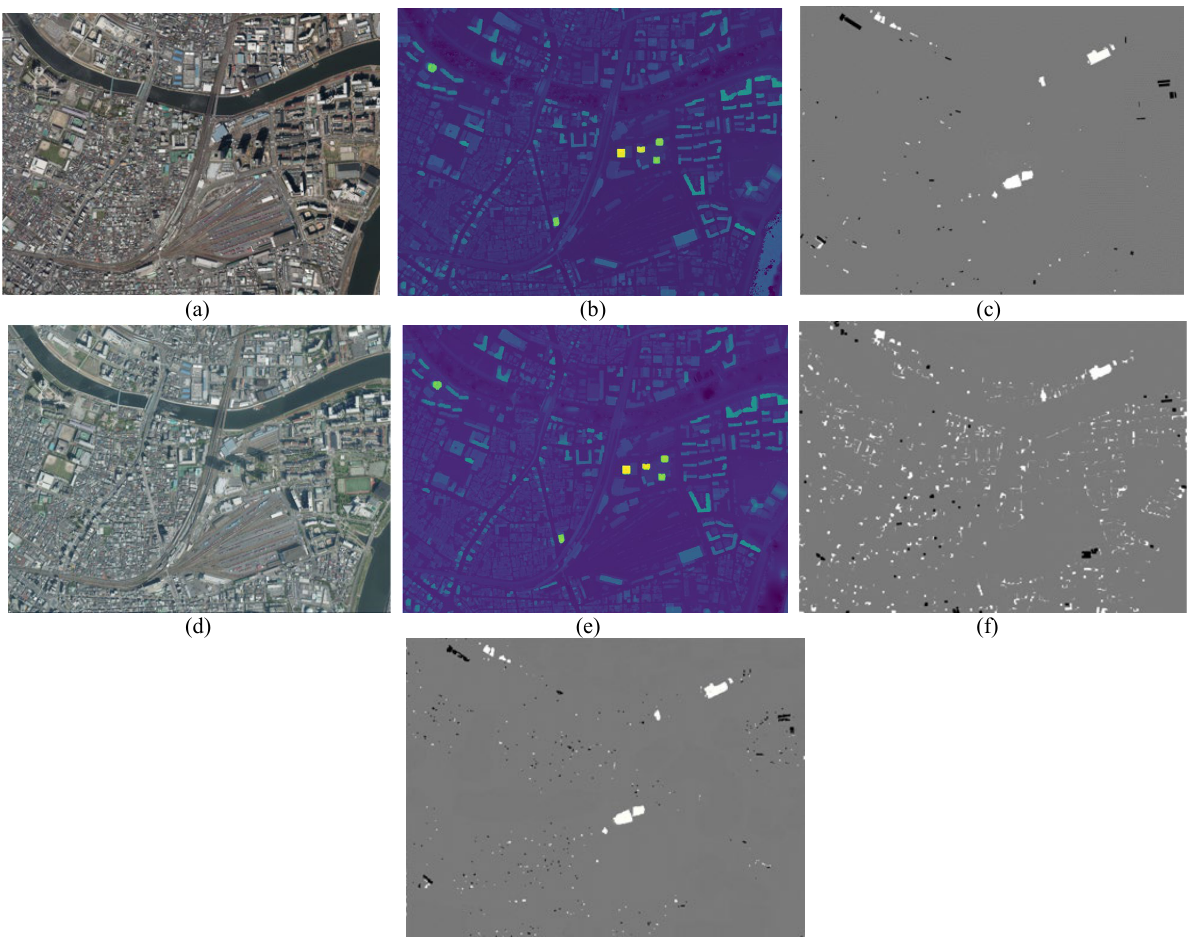
Figure 3. The experimental results of the proposed method. (a) and (d) are two time periods orthophoto, (b) and (e) are the corresponded 3D points cloud, (c) is the ground truth, black means new constructed, grey means unchanged, black means demolished, (f) is the CNN based change detection results, (g) is this paper proposed GNN based change detection